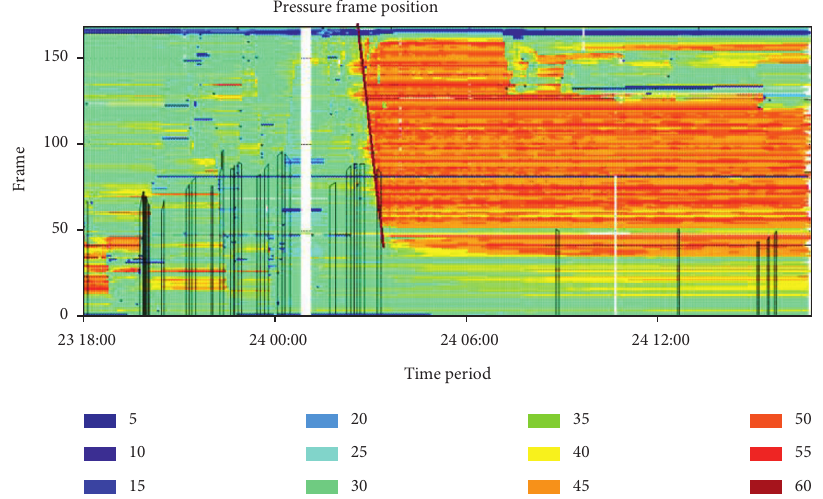
Figure 7: Real-time map of ground pressure during support pressing in the 22306 working